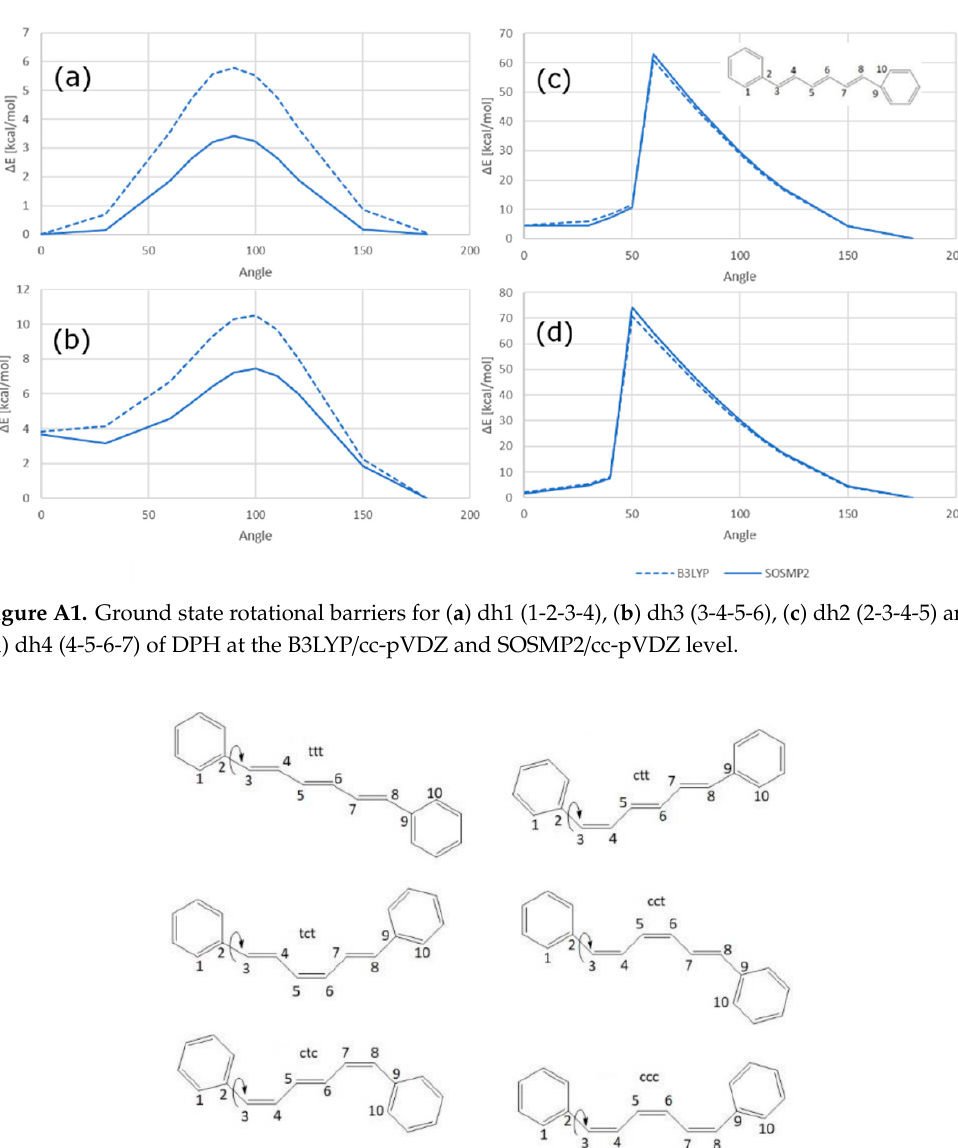
Figure A2. Di ff erent conformers of DPH. Figure A2. Different conformers of DPH. Table A1. Energy di ff erence between the conformers of DPH (see Figure A1) a Table A1. Energy difference between the conformers of DPH (see Figure A1) a .